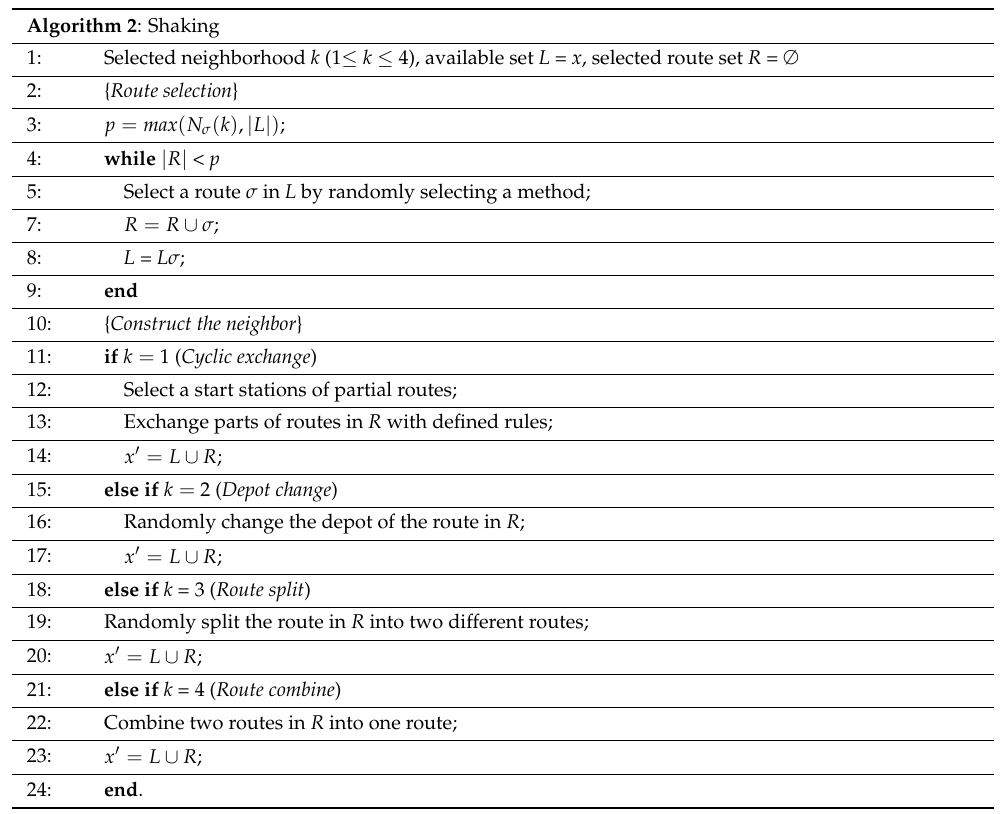
Figure 4. Illustration example of depot change.